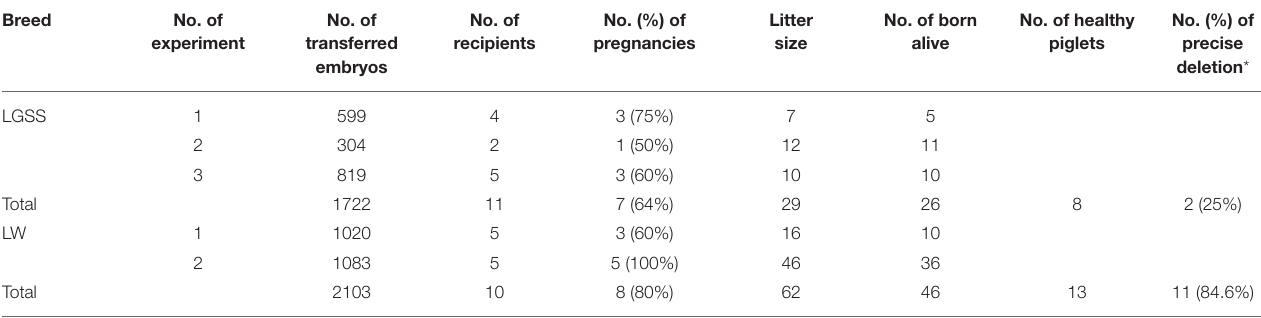
TABLE 1 | Summary of CD163 SRCR5-edited pigs generated through SCNT. Breed No. of